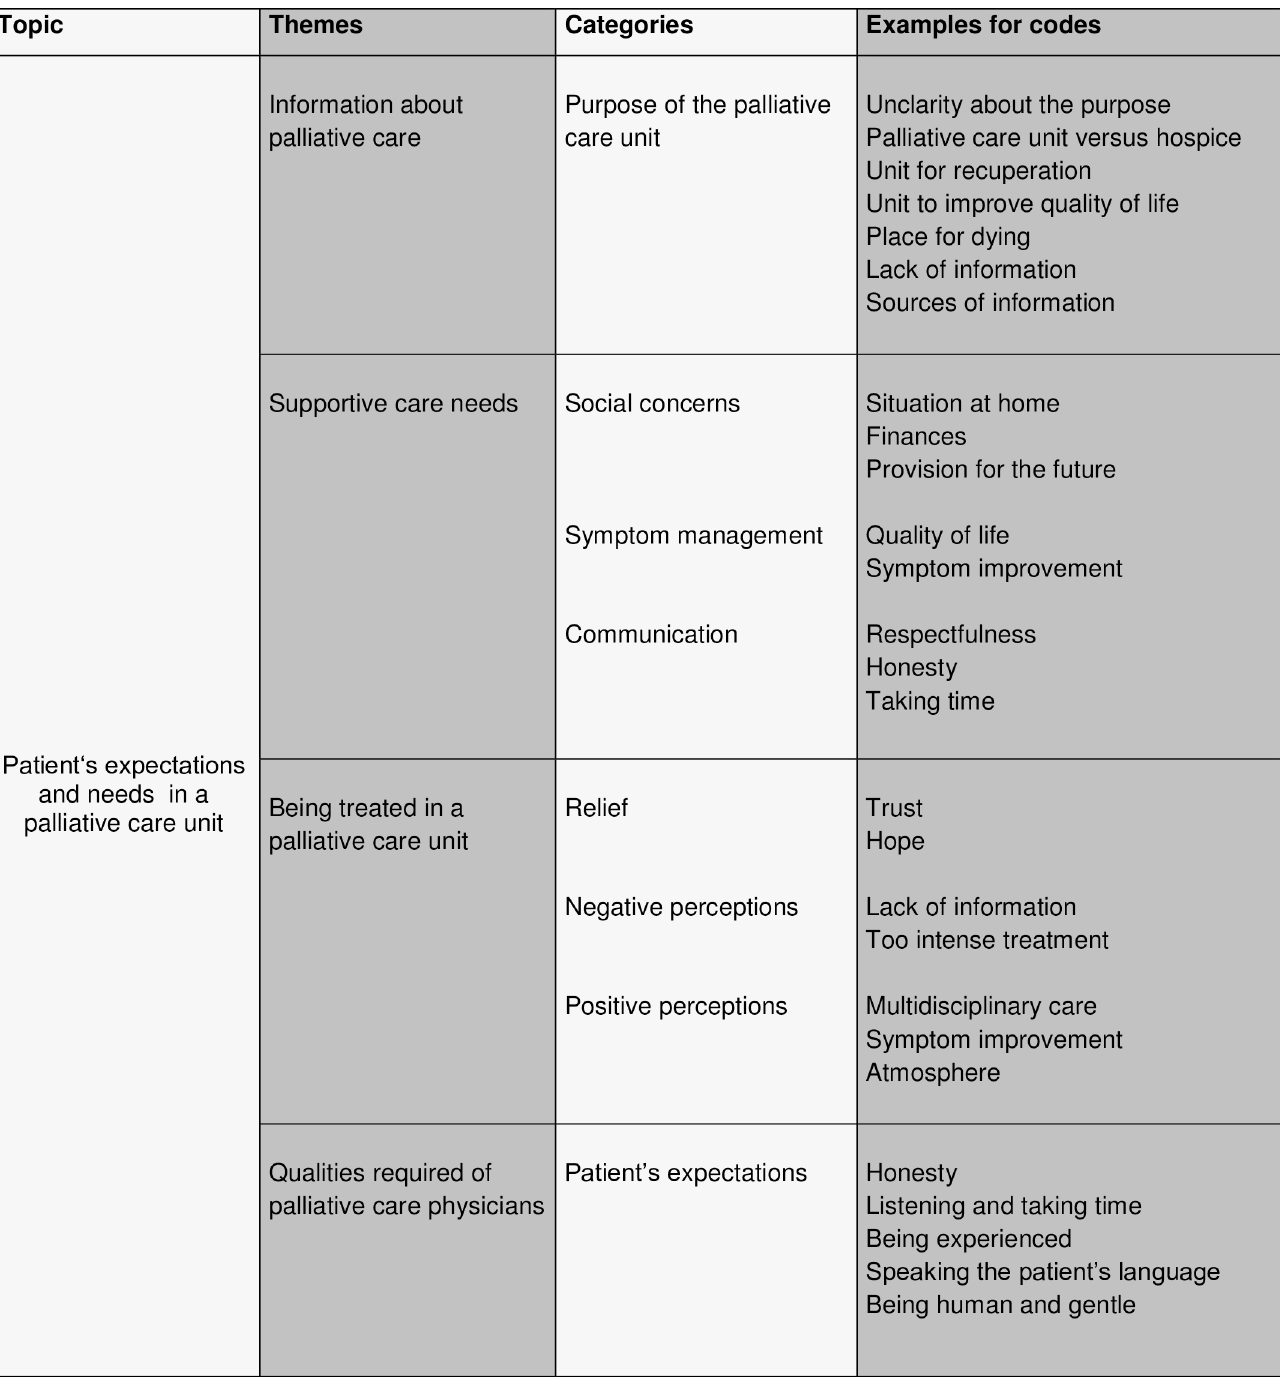
PLOS ONE | DOI:10.1371/journal.pone.0158830 July 7,